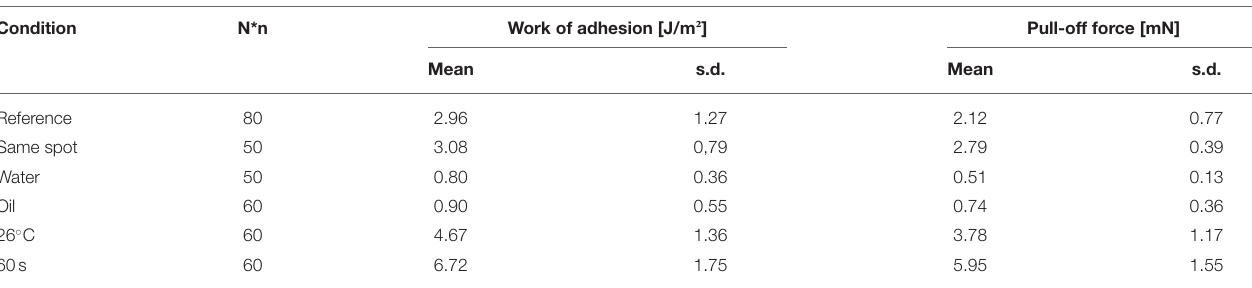
TABLE 1 | Propolis adhesion in different conditions.